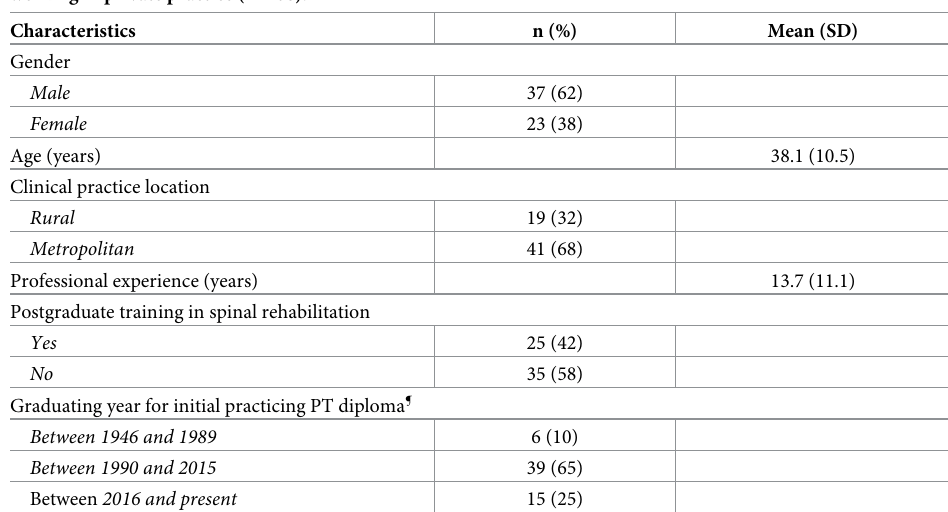
Table 1. Demographic and professional characteristics of the participating French licensed physiotherapists working in private practice (n = 60).